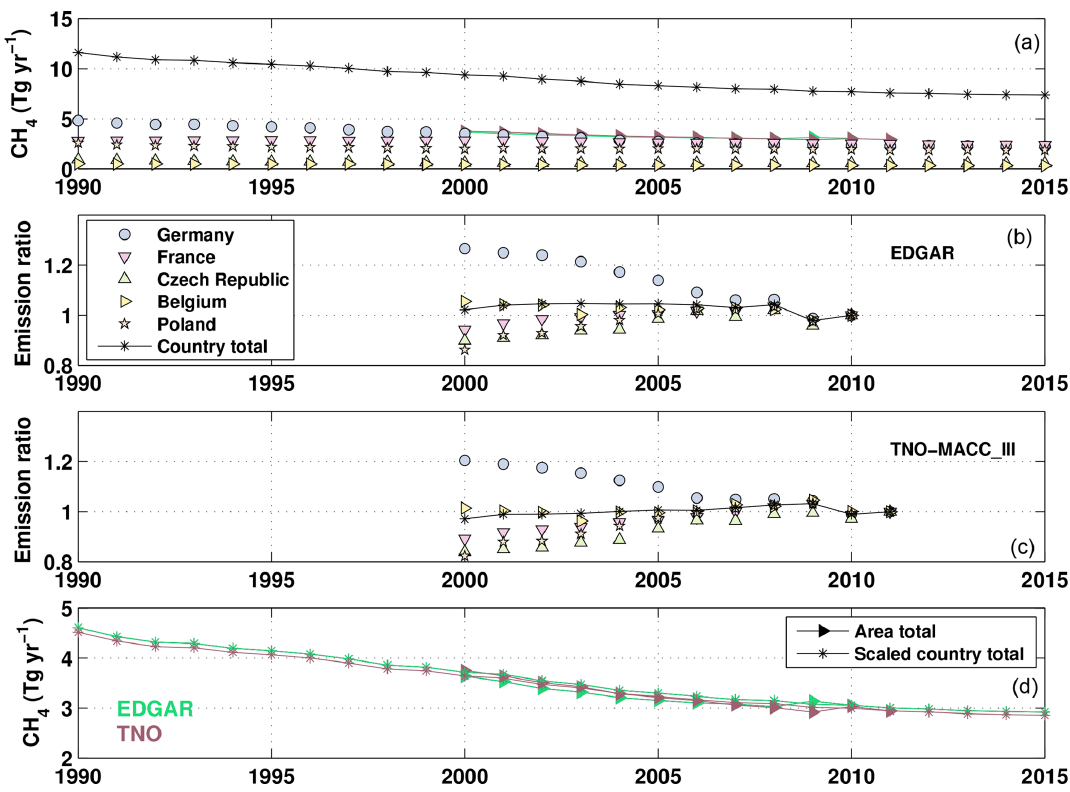
Figure A5. This four-panel plot shows the methodology for scaling the country-level emissions of CH 4 reported to the UNFCCC to extrap- olate the gridded inventory emissions to 2015. The panels and symbols follow the same description as in Fig.